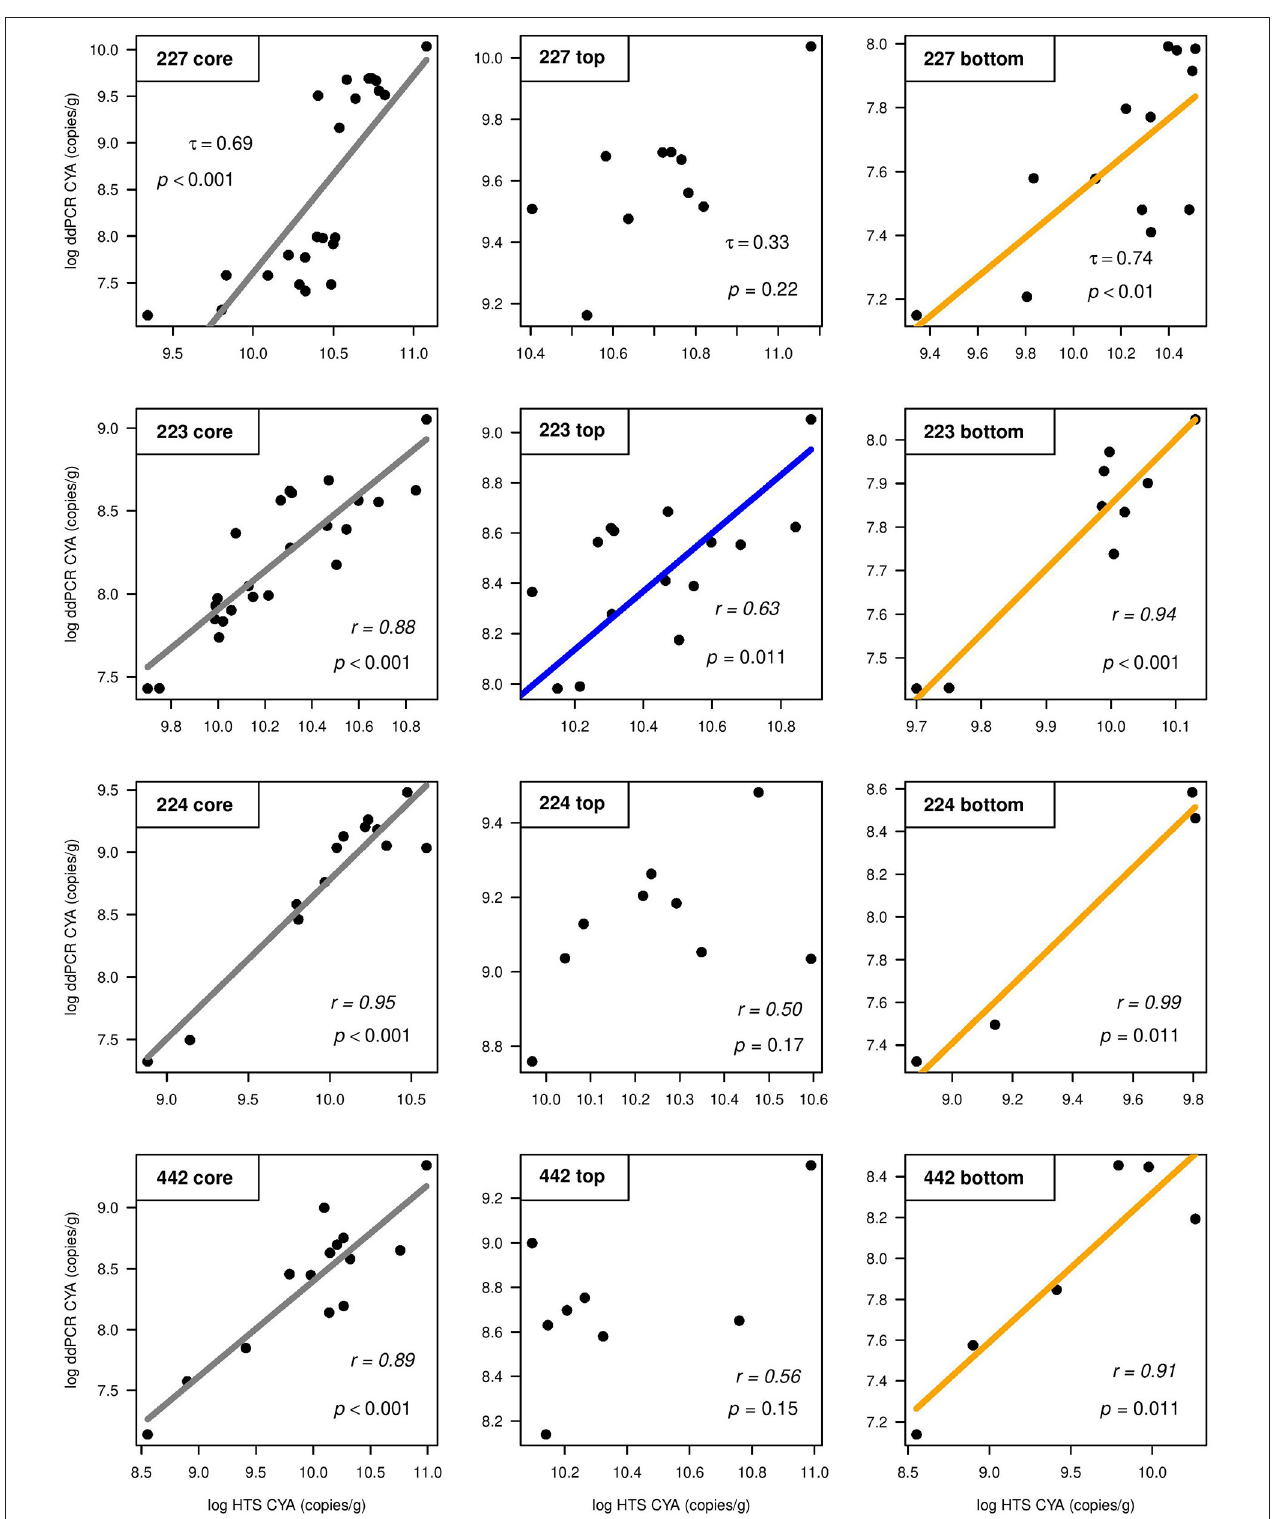
FIGURE 3 | Correlations between log-transformed droplet digital PCR (ddPCR) gene copy numbers and high-throughput sequencing (HTS) amplicon sequence variant counts (using SILVA) for cyanobacterial 16S rRNA (CYA), normalized per gram of dry sediment across the whole core (left), top sediments (middle), and bottom sediments (right) of study lakes 227, 223, 224, and 442. Kendall’s τ (Lake 227) and Pearson’s r (lakes 223, 224, and 442) correlation coefficient values are shown.